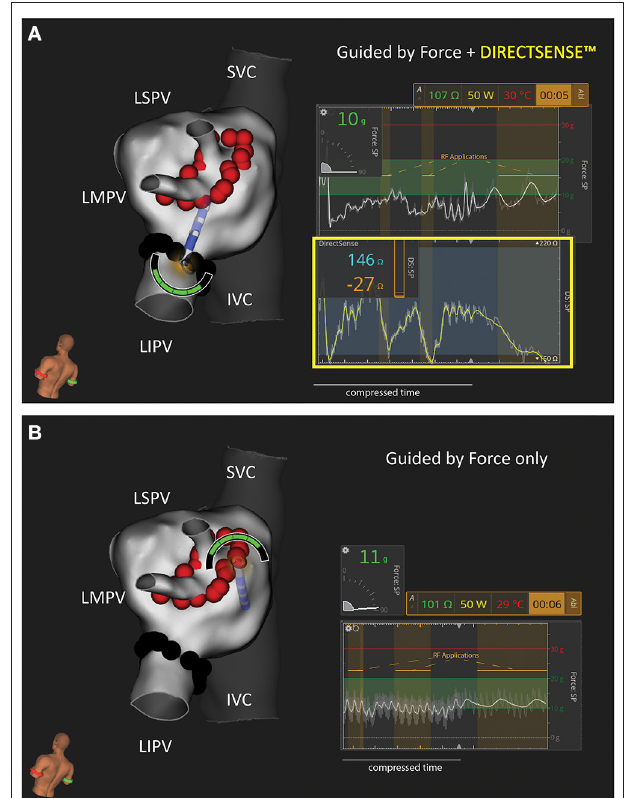
FIGURE 1 | Representative Example of Study Workflows in the Canine Left Atrium. Two test conditions were used to isolate the left sided pulmonary veins in this study: (A) Force and DIRECTSENSE TM feedback visible during RF energy titration or (B) Only Force feedback visible during RF energy titration. In this example the LIPV was randomly assigned to (A) while the LSPV/LMPV was randomly assigned to (B) . N = 4 animals were treated with 50W (as shown in this example). N = 4 separate animals were treated with 30W. The force and local impedance traces include multiple sequential RF applications as highlighted by the gold overlays. IVC, inferior vena cava; LIPV, left inferior pulmonary vein; LMPV, left middle pulmonary vein; LSPV, left superior pulmonary vein; SVC, superior vein